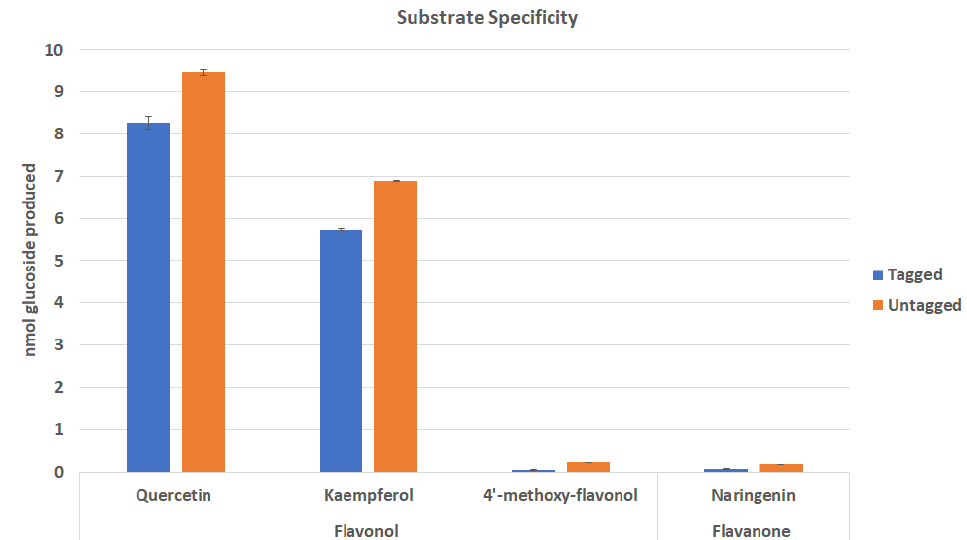
Figure 2. E ff ect of tags on Cp3GT substrate preference. Untagged Cp3GT showed greater activity with the preferred flavonol substrates quercetin and kaempferol. There was no significant activity with methoxylated flavonols or flavanones. n = 2.